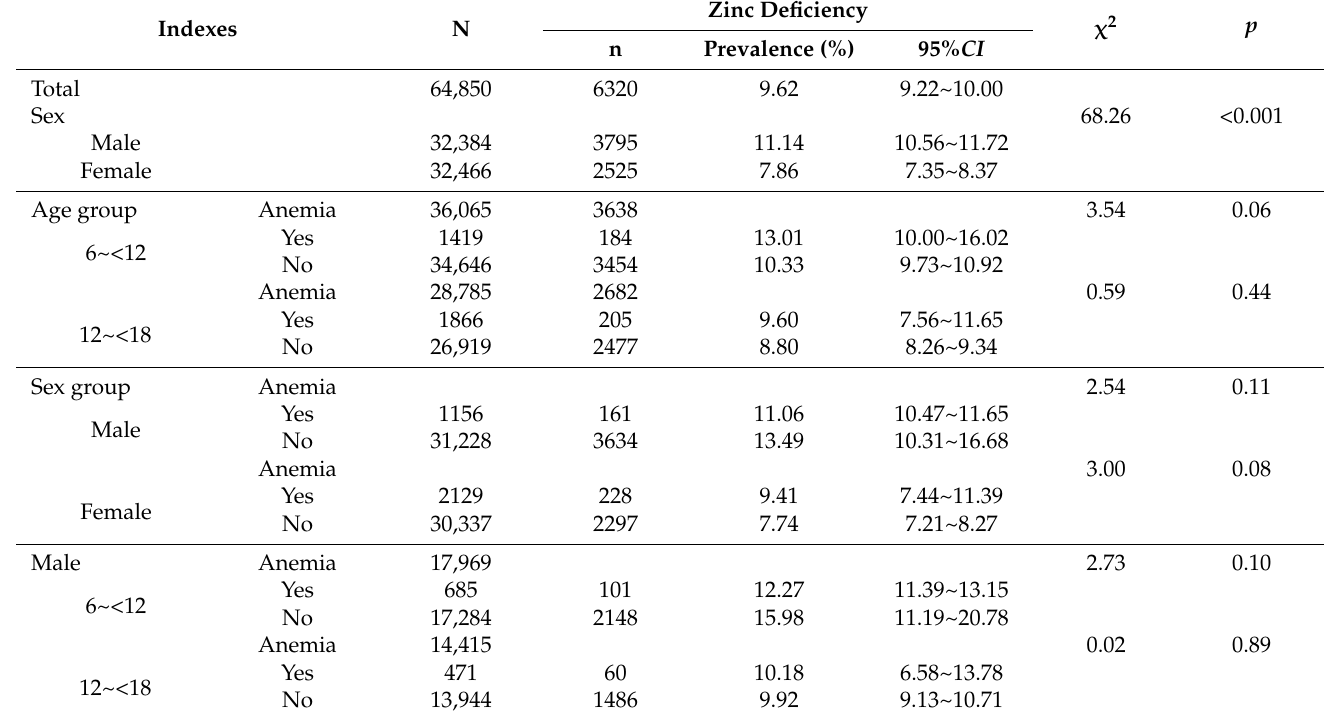
Table 4. Association between anemia and zinc deficiency in different age